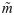
Trajectory continuity correction.The yellow curve shows incomplete data of a marker trajectory (m) on which a gap was introduced between frames 1130 and 1190 (only z-axis is shown). The blue curve represents the recovered data (m˜), and the red curve shows the corrected data using trajectory continuity constraint (m˘) (see Eqs 16–19).